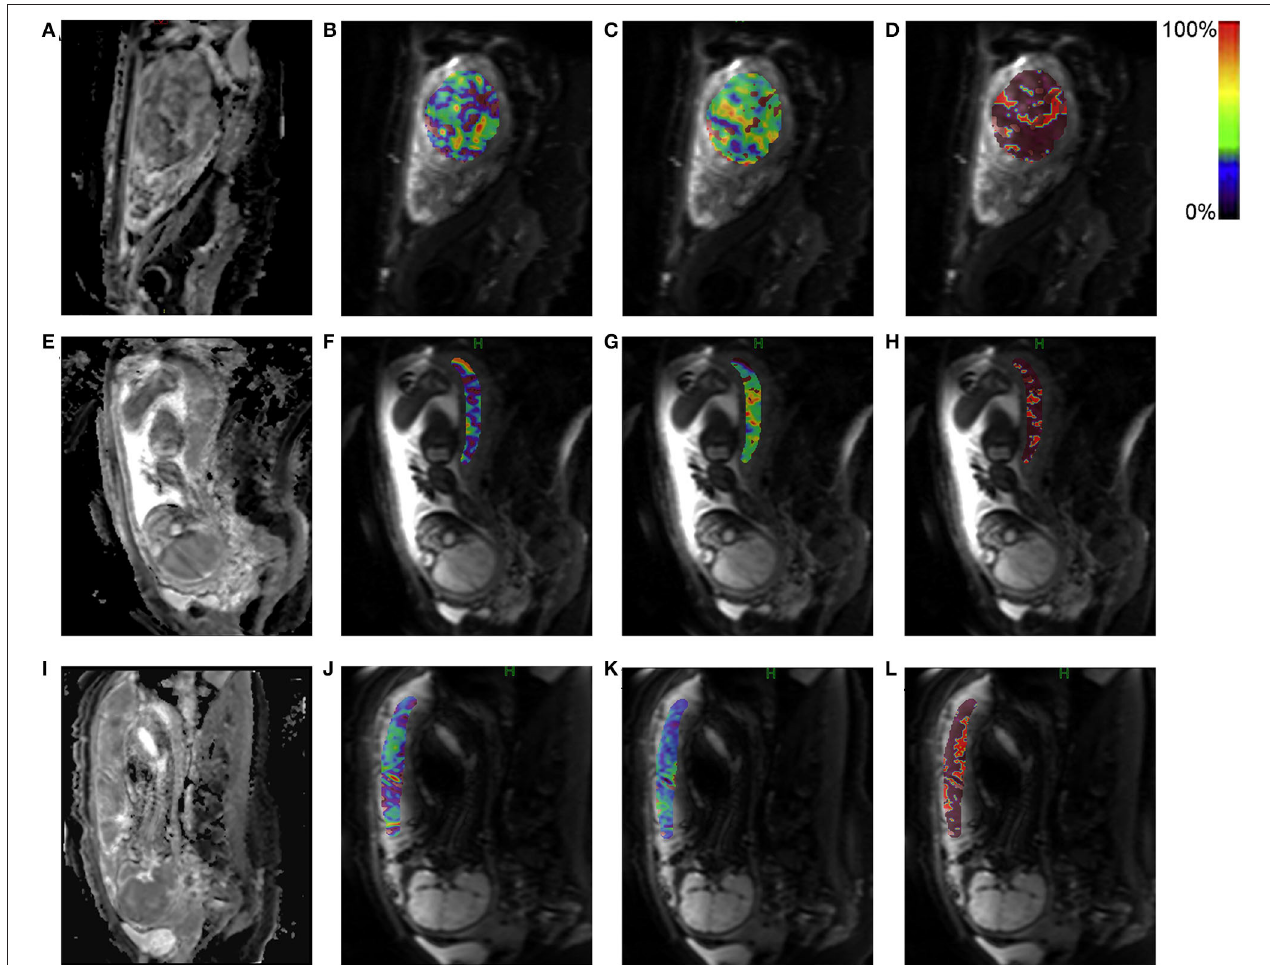
FIGURE 1 | Representative intravoxel incoherent motion (IVIM) parametric maps for placental perfusion. The upper panel shows the IVIM parametric maps of a pregnant woman with a normal placental perfusion. The middle and lower panels respectively show low and lower placental perfusion of different pregnant women. (A,E,I) : Diffusion weighted image at b-value = 0 mm 2 /s; (B,F,J) : Perfusion fraction f p ; (C,G,K) : True diffusivity D t ; (D,H,L) : Pseudo diffusivity D p . The region of interest was drawn on diffusion weighted image (b = 0 mm 2 /s) and then transferred to the other maps with corresponding pseudo color bar indicating the range of